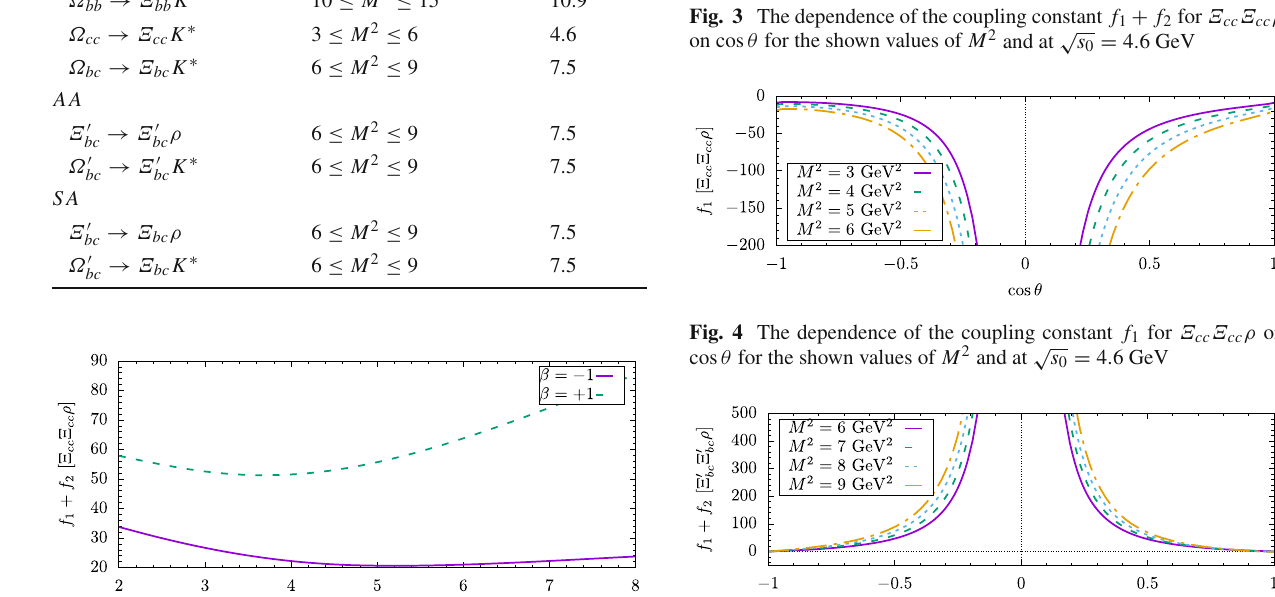
Fig. 1 The dependence of the coupling constant f 1 + f 2 for Ξ cc Ξ cc ρ on M 2 for the shown values of β and at